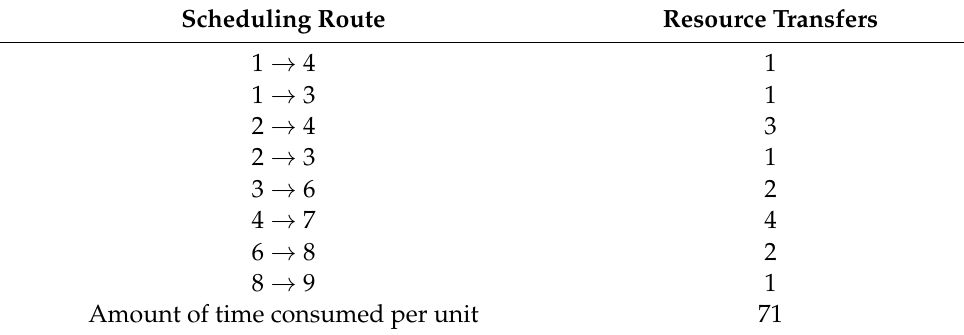
Table 6. RQRCS scheduling storage resource calculation